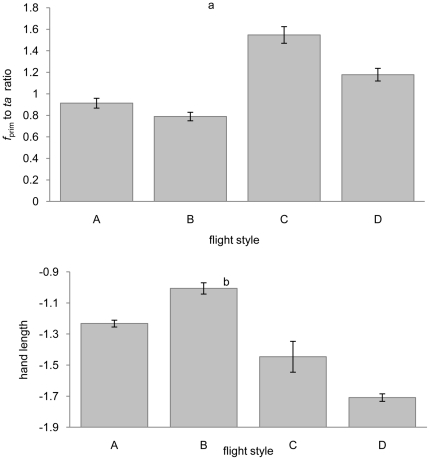
Mean primary feather length compared to total arm length (f
prim/ta) and mn length for the four flight style groups of Bruderer et al.
[18] (a) A one-way ANOVA showed that f
prim/ta was significantly different between four flight styles (F
3,182 = 37.789, P<0.001): back transformed mean f
prim/ta ratio were group A = 0.9131 (0.8685, 0.9557), B = 0.7889 (0.7190, 0.8588), C = 1.5471 (1.0835, 2.0107) and D = 1.1782 (1.1319, 1.2244). (b) ANCOVA with body size controlled showed that mn length was significantly different between the four flight styles (F
3,182 = 95.708, P<0.001): back transformed mean mn lengths for group A = −1.2326 (−1.2762, −1.1890), B = −1.0062 (−1.0823, −0.9301), C = −1.446 (−1.6814, −1.2114), D = −1.7088 (−1.7572, −1.6604).